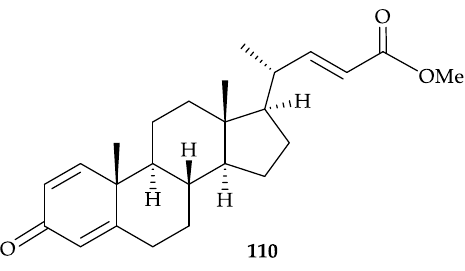
Figure 19. Structure of methyl 3-oxochola-4,22-dien-24-oate ( 110 ).